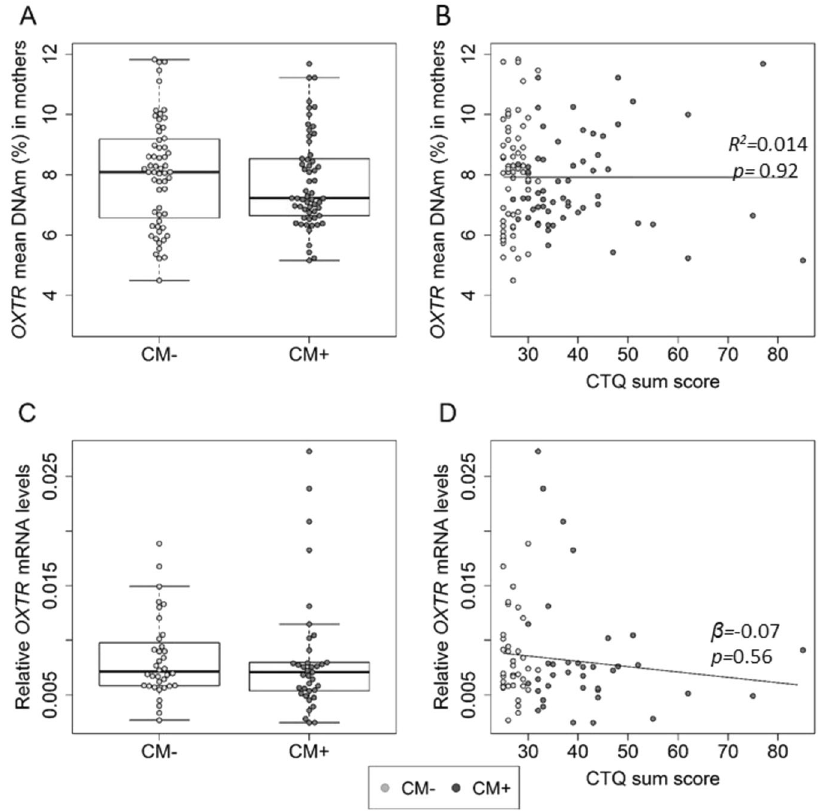
Fig. 2 Association between CM and OXTR epigenetic regulation in mothers. A OXTR DNAm did not differ between mothers with childhood maltreatment experiences (CM + ; marked with dark points) and without (CM − ; marked with light points) (N = 107, F (1,101) = 0.34, p = 0.56 ) . B The severity of CM experiences (measured as the CTQ sum score) did not correlate with maternal OXTR DNAm ( R 2 = 0.014, p = 0.92). C , D The relative OXTR- gene expression did not differ between CM + and CM − mothers ( N = 73, β = − 0.01, p = 0.93) and did not correlate with the severity of CM ( N = 73, β = − 0.07, p = 0.56). Whiskers indicate variability outside the upper and lower